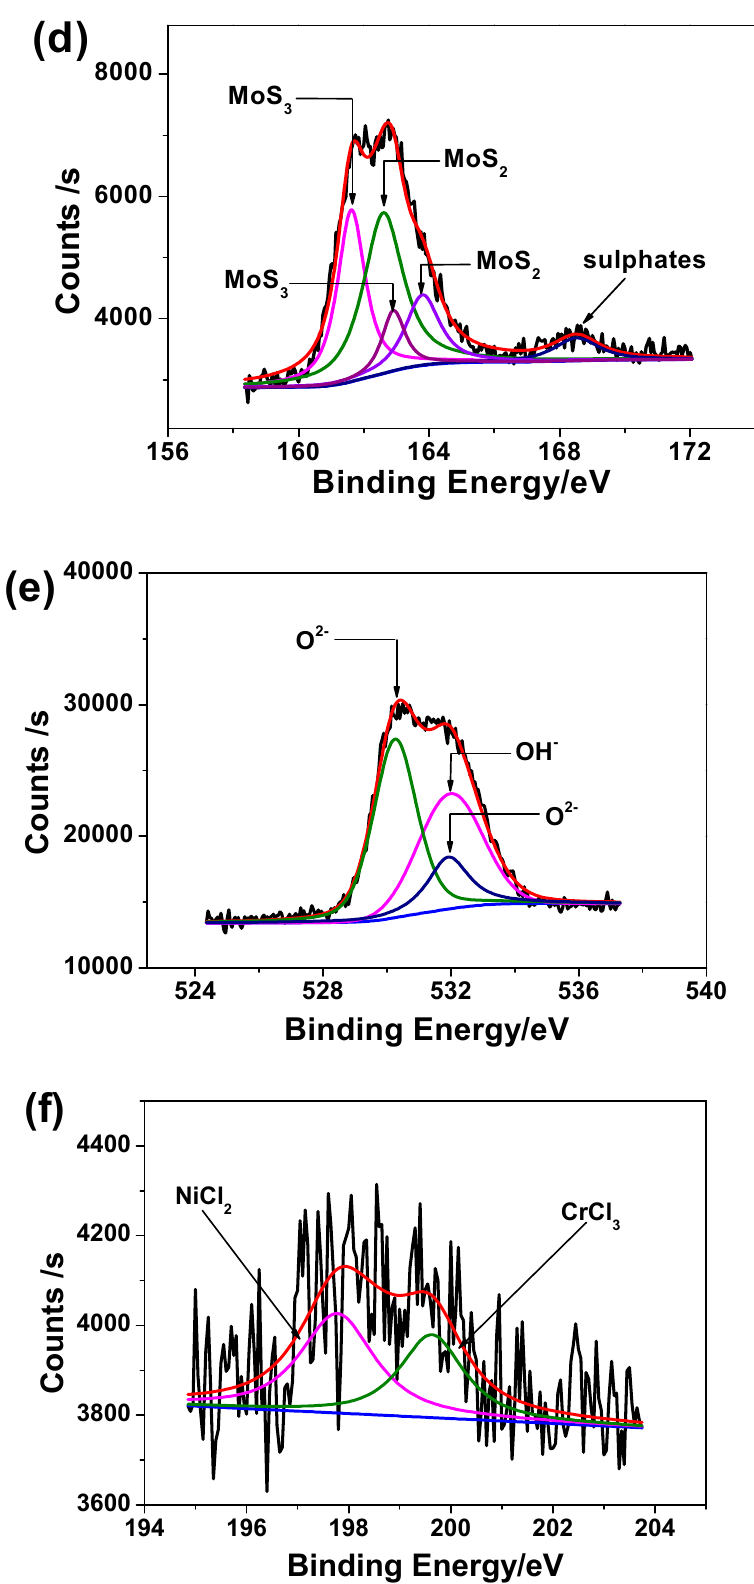
Figure 9. High-resolution scanning XPS spectra of ( a ) Cr 2p, ( b ) Mo 3d, ( c ) Ni 2p, ( d ) S 2p, ( e ) O 1s and ( f ) Cl 2p in corrosion product film on 2205 DSS surface after immersion in 137 mol/L HCl solution with 0.385 mmol/L Na 2 S at 90 °C for 8 h.